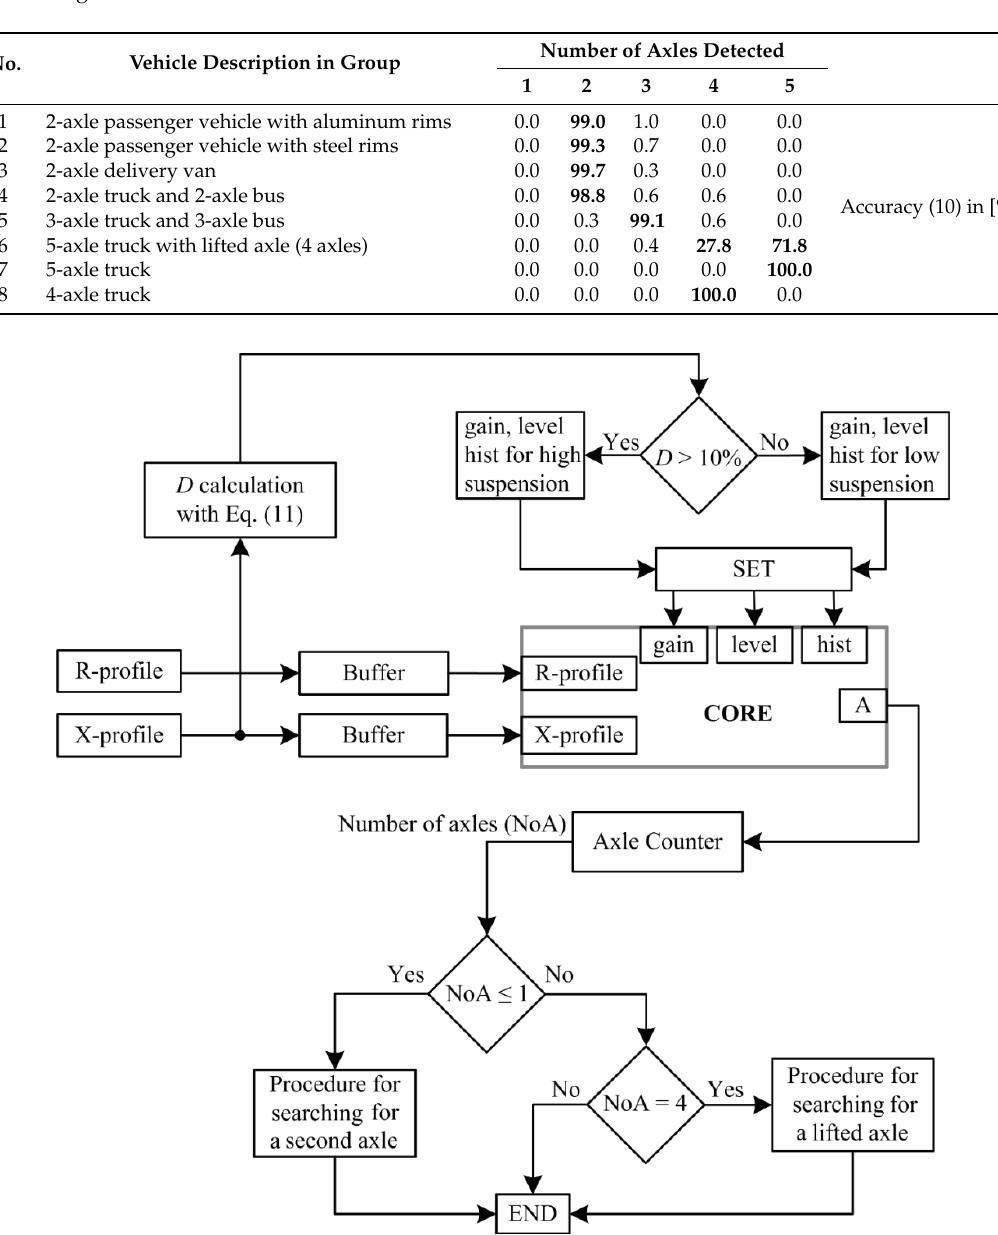
Figure 8. Vehicle axle detection algorithm based on R- and X-profiles.